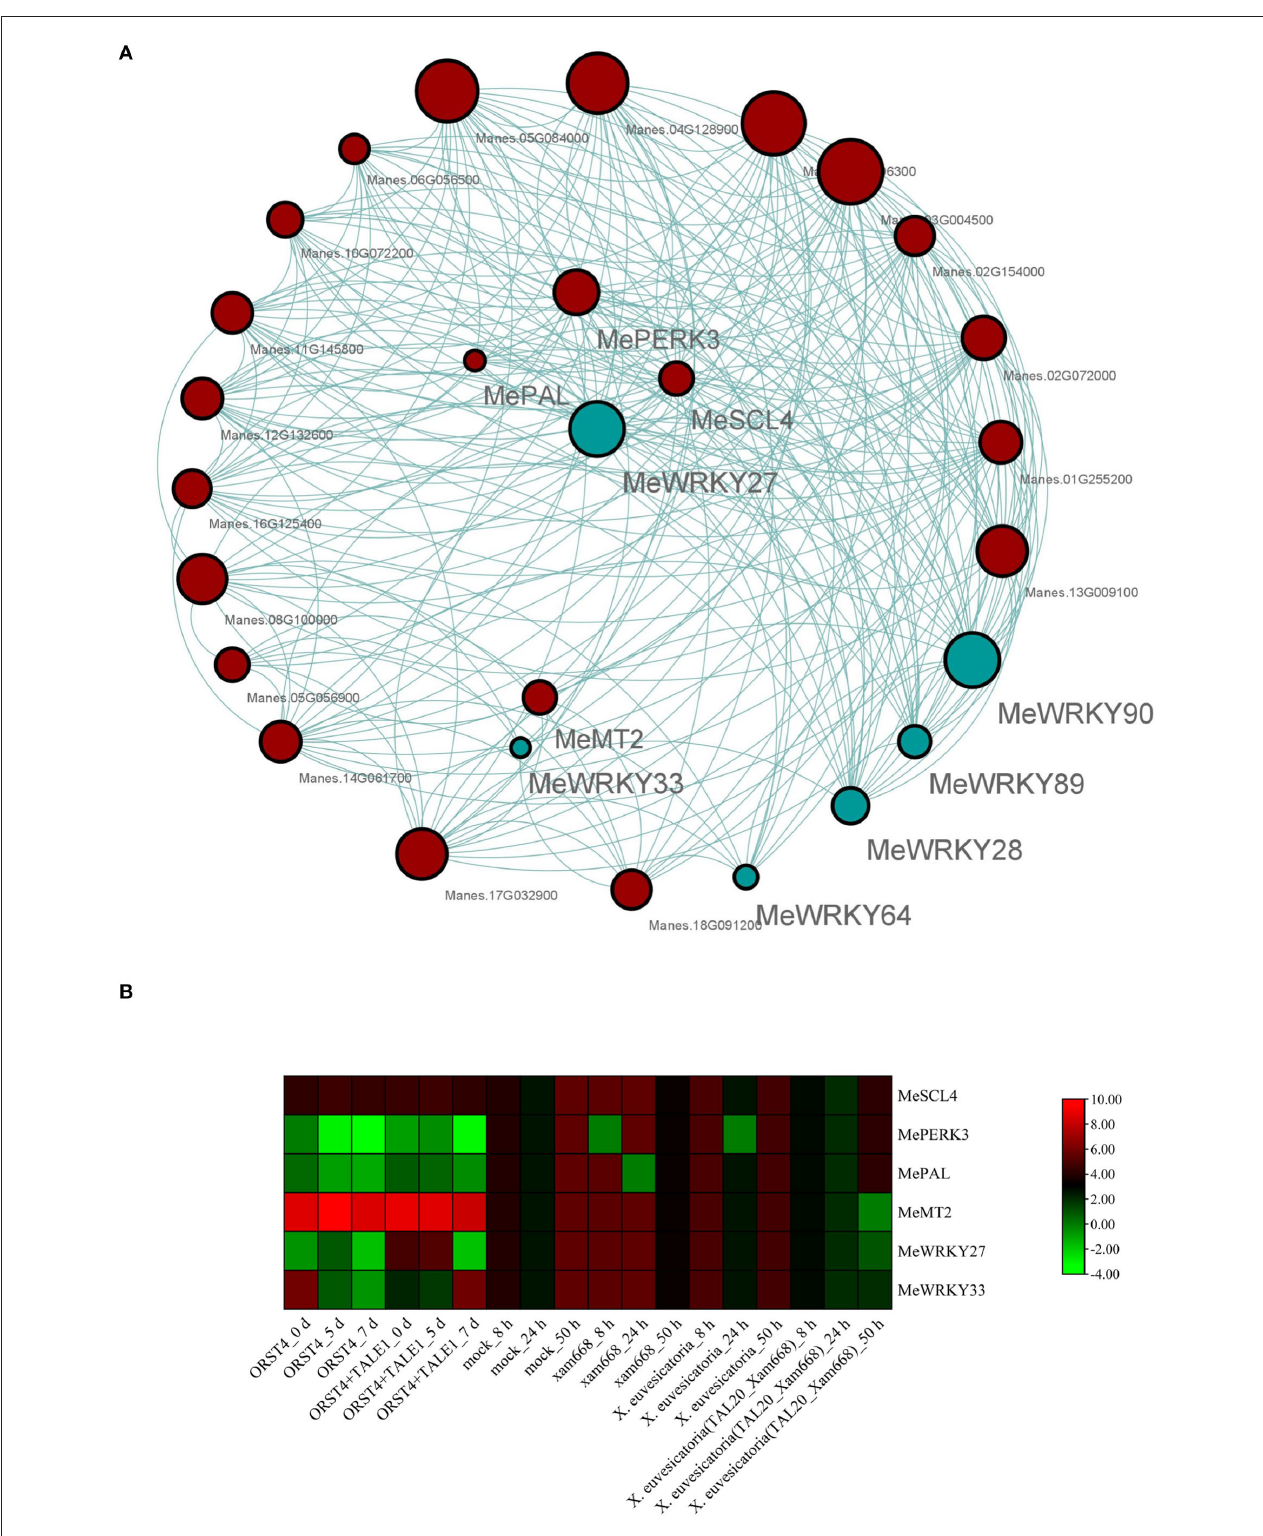
FIGURE 9 | Co-expression analysis of MeWRKY IIas and W-box gene. (A) The co-expression network of MeWRKY IIas and W-box genes in the turquoise module. Blue and red circles represent MeWRKY IIas and W-box containing genes, respectively. (B) Expression profiles of MeWRKY IIas and selected W-box genes in response to various pathogen